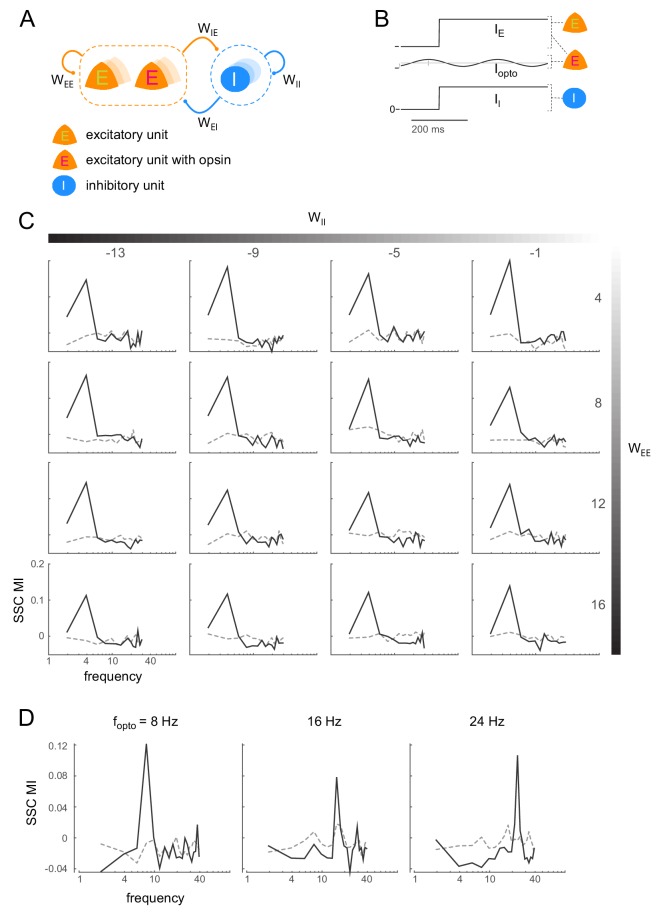
Induction of coherent activity in the E-I model is robust across network and stimulation parameters - I.(A)-(B) same as Figure 6A-B. (C) Spike-spike coherence modulation index (SSC MI; see Figure 6D) as a function of varying the self-coupling parameters Wee and Wii, keeping the other two parameters fixed (Wie=4,Wei=-18). SSC MI exhibits a peak at the 4Hz optical stimulation frequency irrespective of the self-coupling parameters. The dotted lines represent the null SSC MI obtained by shuffling trial identities. (D) The peak SSC MI shifts with increasing optical stimulation frequency (fopto, network parameters same as in Figure 6), indicating that the peak is not due to any intrinsic resonant activity in the network. Dotted lines same as in (C).